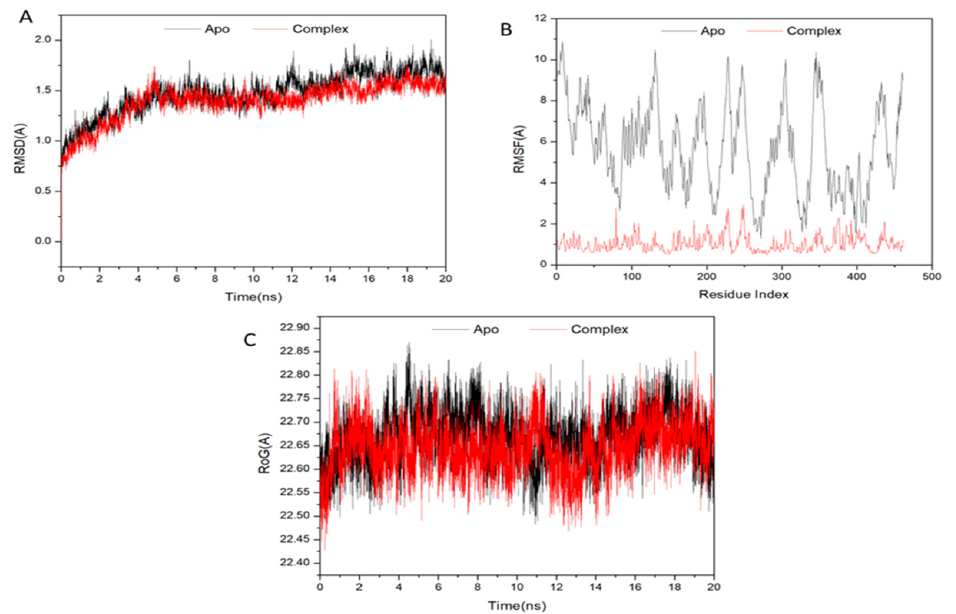
Figure 5. ( A ) RMSD of C α atoms of the protein backbone atoms; ( B ) RMSF of each residue of the protein backbone C α atoms; ( C ) Radius of Gyration (ROG) of C α atoms of protein residues of the backbone atoms relative (black) to the starting minimized over 20 ns for the P450 CYP2C9 protein with ligand ATX (red).